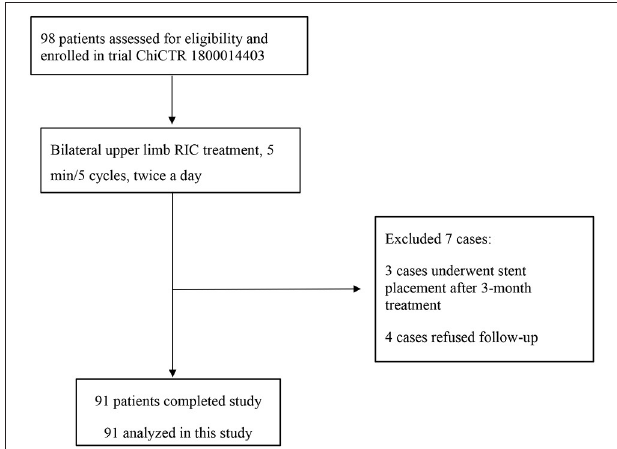
FIGURE 1 | Enrollment